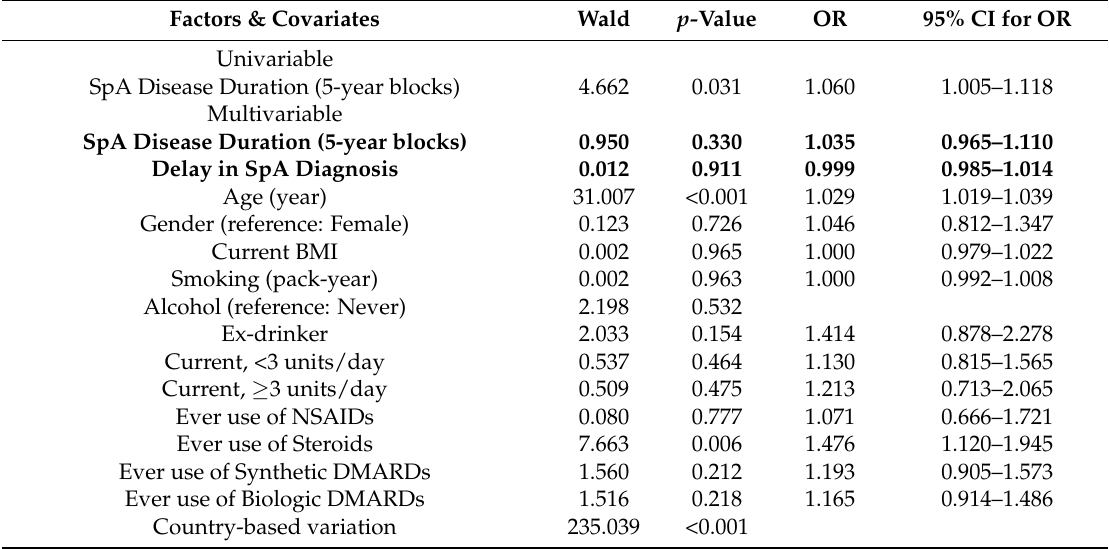
Table 1. Risk of upper gastrointestinal ulcers associated with longer disease duration in participants with spondyloarthritis